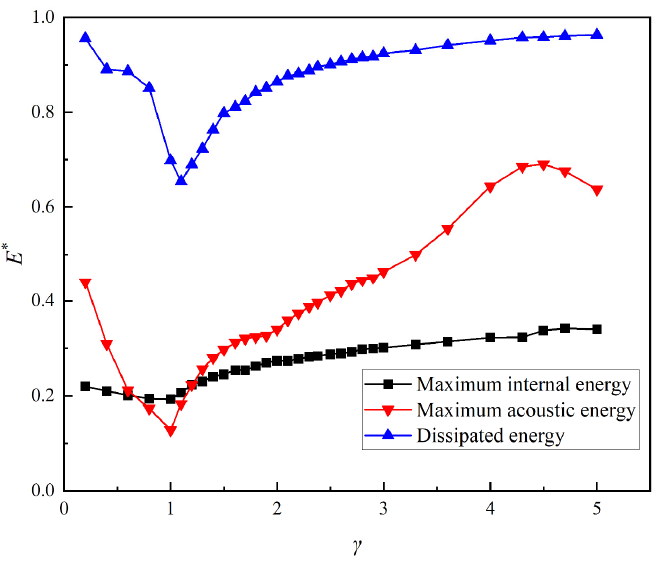
Figure 14. Maximum internal energy, maximum acoustic energy, and dissipated energy in the first cycle under different γ values.